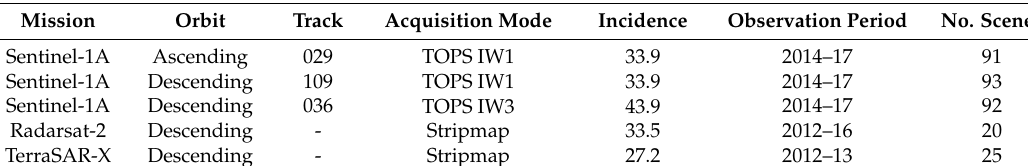
Table 1. Overview of SAR data in-use.